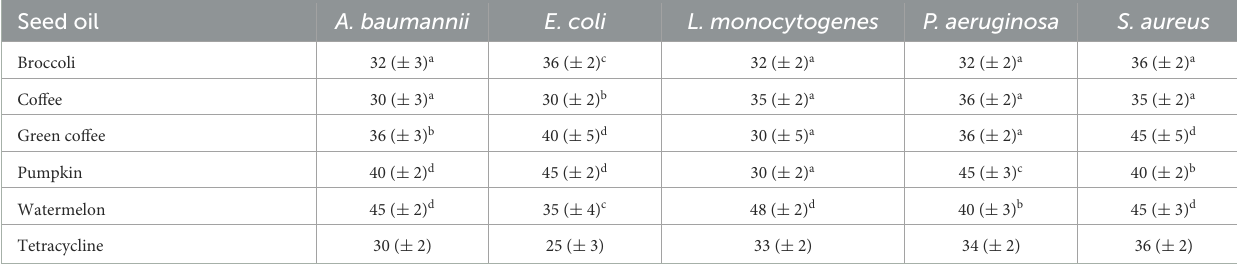
TABLE 3 Minimal inhibitory concentration (MIC, µ g/ml) of the seed oils, needed to block the metabolic activity of the five bacterial strains. Seed oil